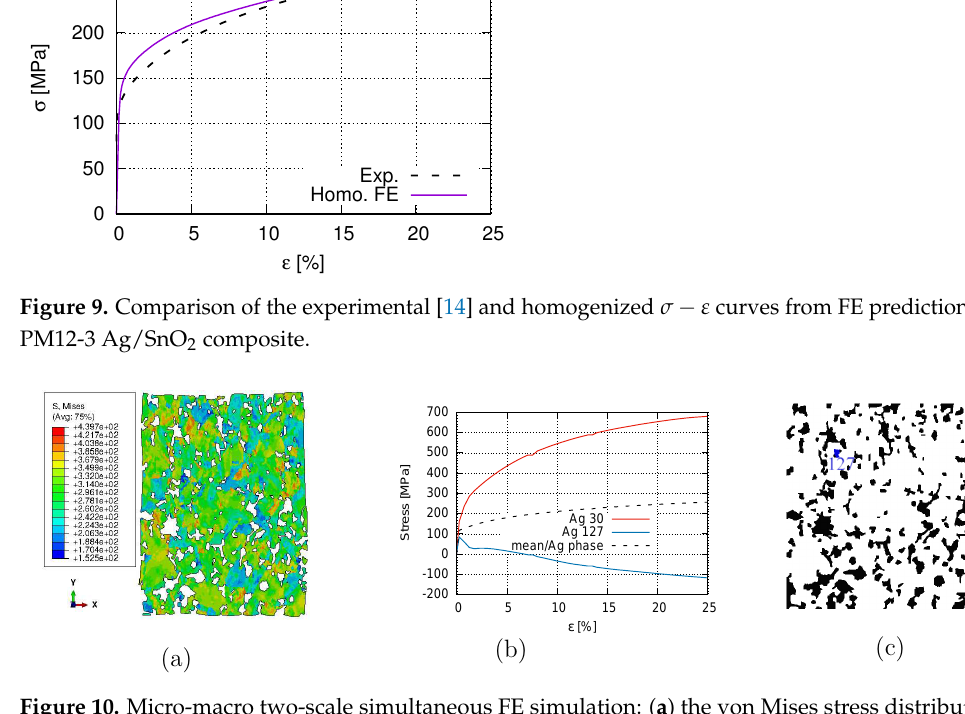
Fig. 10: Micro-macro two-scale simultaneous FE simulation: (a) the von Mises stress distribution of the Ag phase and the deformed edges of the microstructure at 25% global strain; (b) the stress flow behavior according to the global strain: Ag phase mean value and two Ag grains possessing the maximum and the minimum stress at a given strain; (c) positions of the two grains in (b) together with black-colored particles.